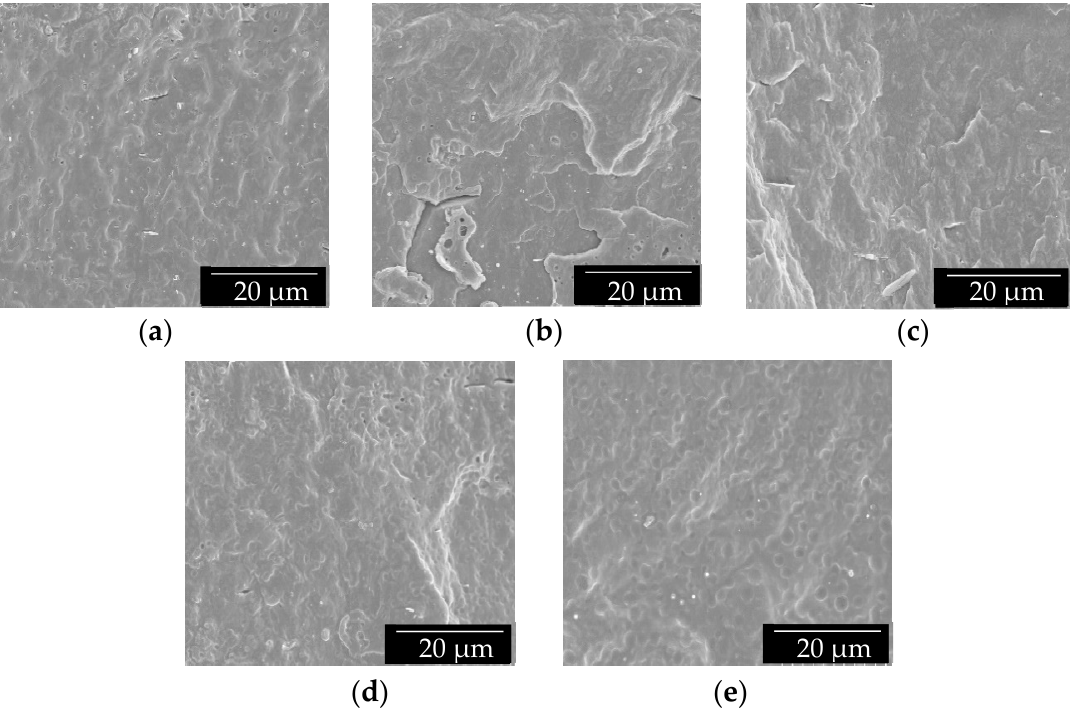
Figure 1. Scanning electron microscopy (SEM) images of the cross-sections of the thermo-compressed films made of poly(3- hydroxybutyrate- co -3-hydroxyvalerate) (PHBV) and poly(3-hydroxybutyrate- co -3-hydroxyvalerate- co -3-hydroxyhexanoate) [P(3HB- co -3HV- co -3HHx)]: ( a ) PHBV; ( b ) PHBV90/P(3HB- co -3HV- co -3HHx)10; ( c ) PHBV75/P(3HB- co -3HV- co -3HHx)25; ( d ) PHBV50/P(3HB- co -3HV- co -3HHx)50; ( e ) P(3HB- co -3HV- co -3HHx). Images were taken at 2000x with scale markers of 20 µm.